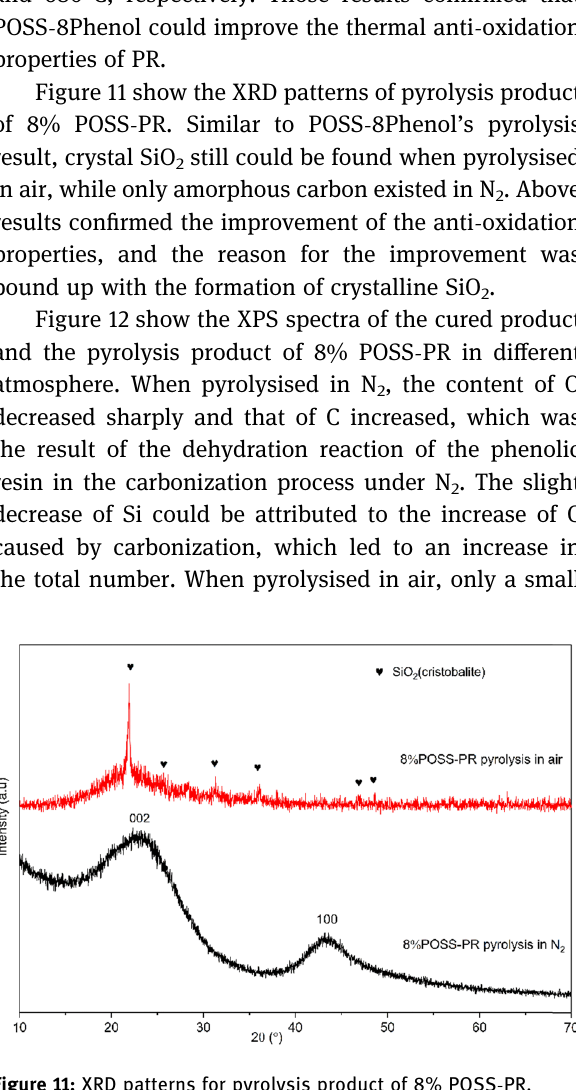
Figure 11: XRD patterns for pyrolysis product of 8% POSS - PR.